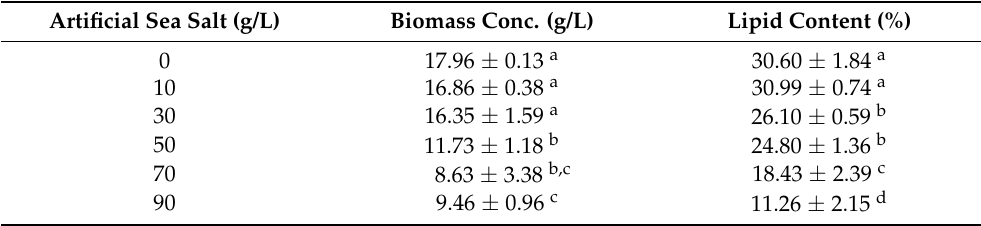
Table 2. Biomass concentration and lipid content of Mortierella alpina FU30797 in different artificial sea salt